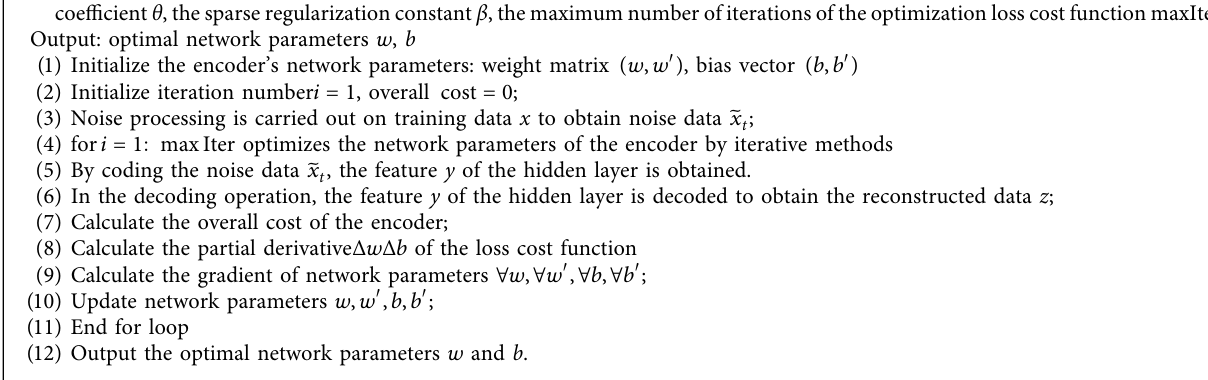
A LGORITHM 1: Specific algorithm of training encoder.